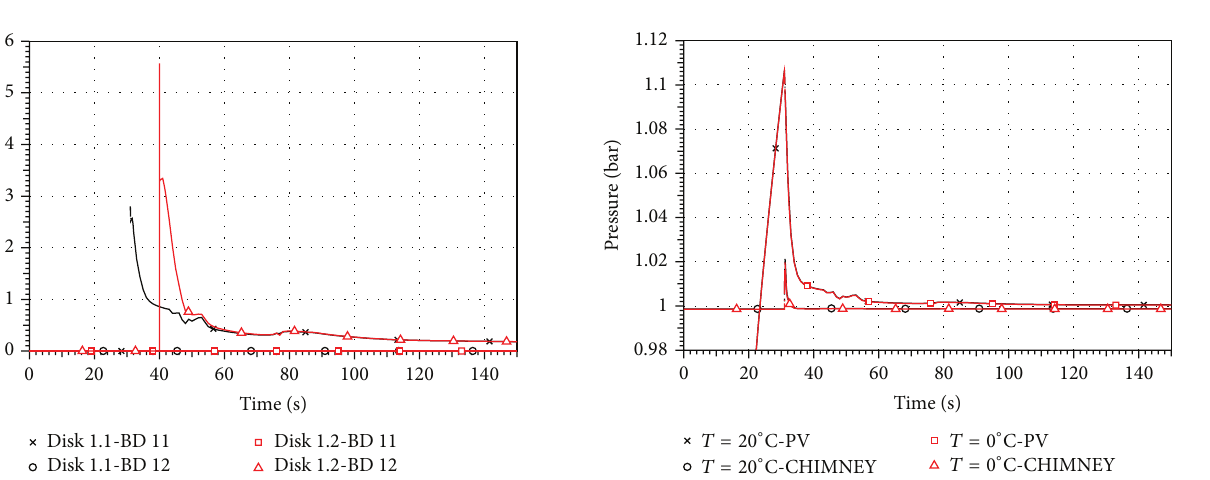
Figure 13: Failure of opening of burst disk at 1.1 bar: flow rate through the burst disks.